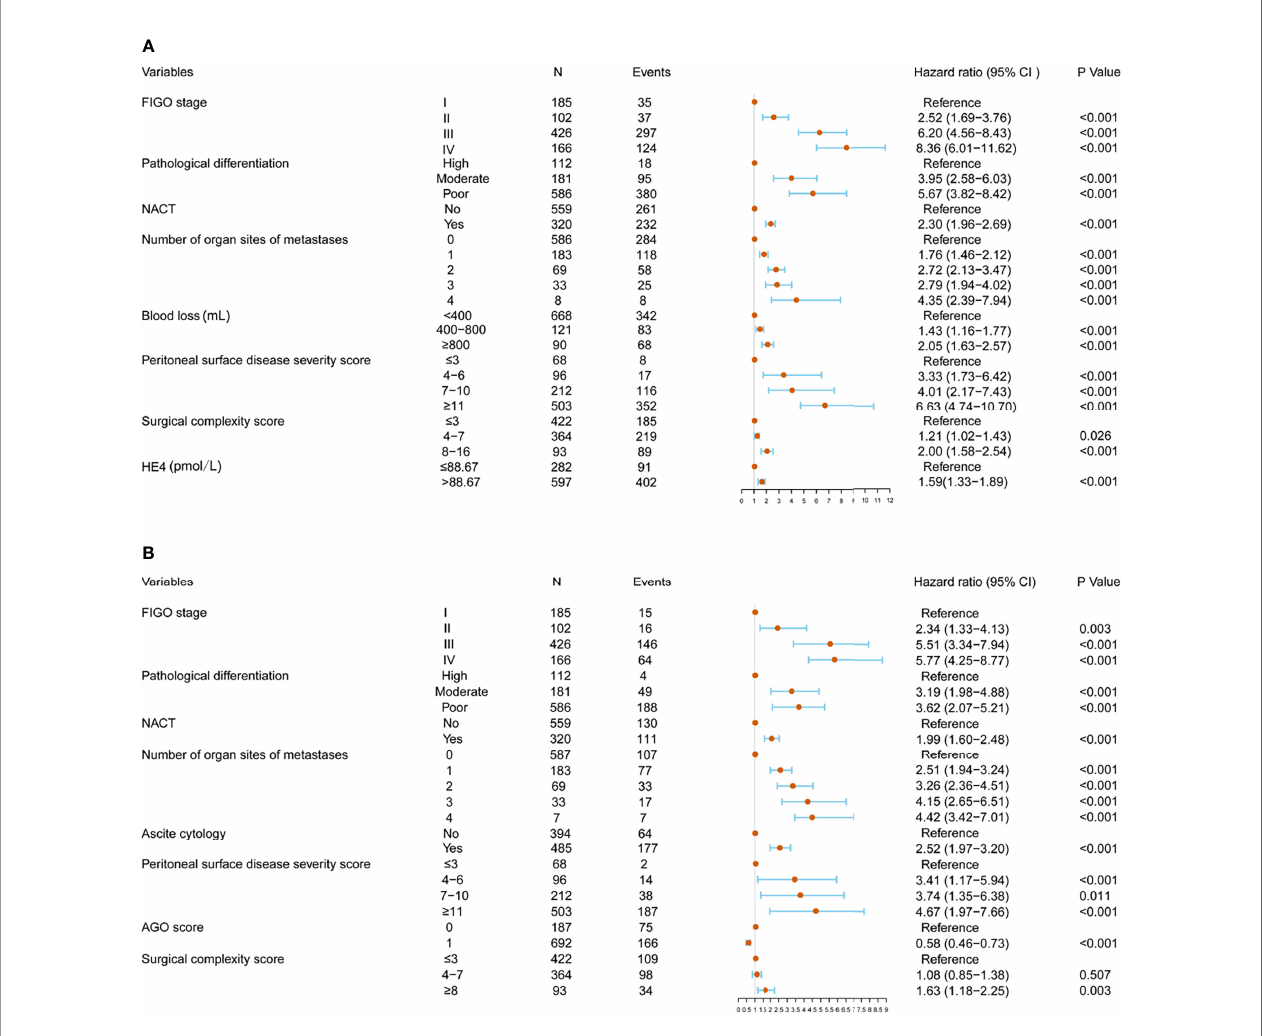
FIGURE 2 | Multivariate analysis and forest plot of the hazard ratios for progression-free survival (PFS) (A) and overall survival (OS) (B) in the training